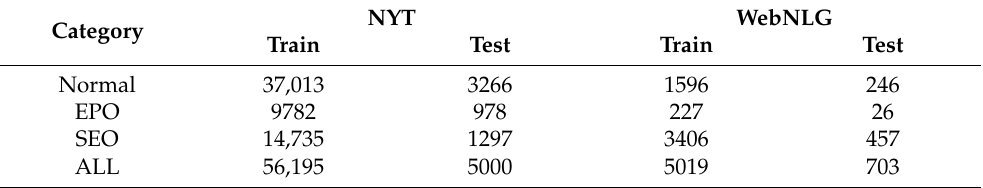
Table 1. Statistics of datasets. Note that a sentence can belong to both EPO class and SEO class.